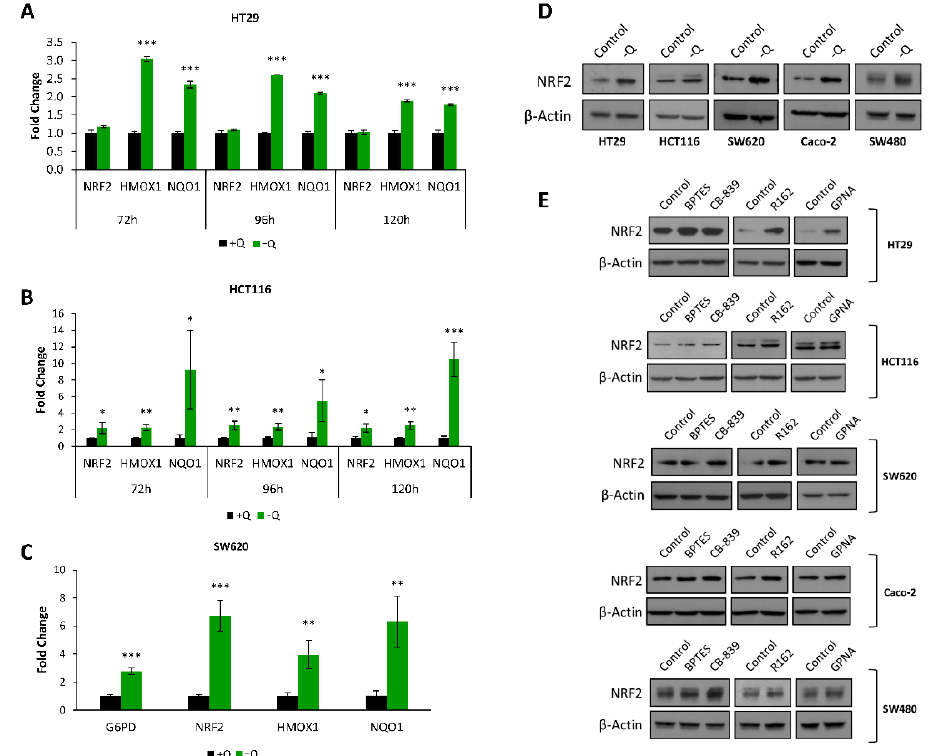
Figure 5. NRF2 and its targeting genes are modulated by glutamine availability. ( A , B ) NRF2 , HMOX1 and NQO1 mRNA expression levels 72, 96 and 120 h after depriving ( A ) HT29 and ( B ) HCT116 cells of glutamine. ( C ) G6PD , NRF2 , HMOX1 , and NQO1 mRNA expression levels 96 h after depriving SW620 cells of glutamine. Fold change was calculated with respect to cells cultured with a medium containing glutamine. ( D ) NRF2 protein levels 24 h after withdrawal of glutamine from the culture medium. ( E ) NRF2 protein levels after 24 h-treatment with BPTES (10 µ M), CB-839 (5 µ M), R162 (20 µ M), and GPNA (100 µ M). One asterisk (*) denotes p -value < 0.05, two asterisks (**) denote p -value < 0.01 and three asterisks (***) denote p -value <